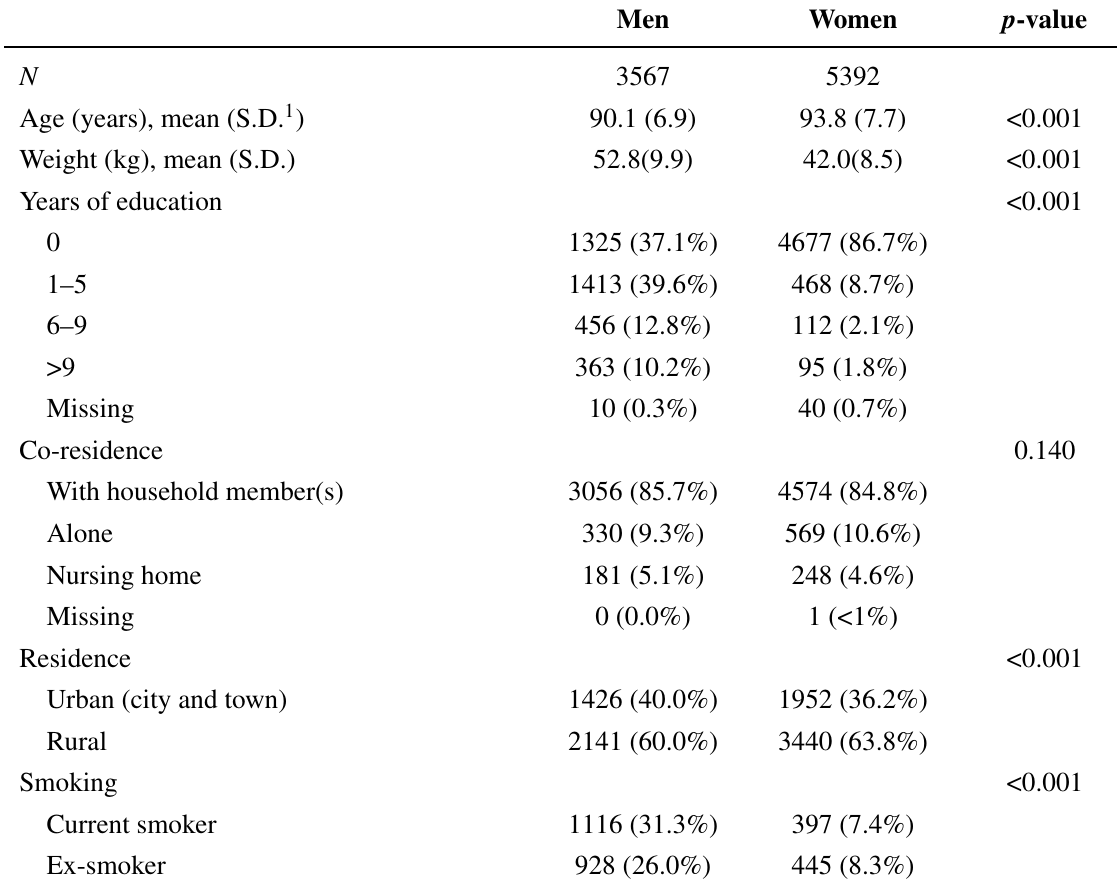
Table 1. Sample characteristics ( n =